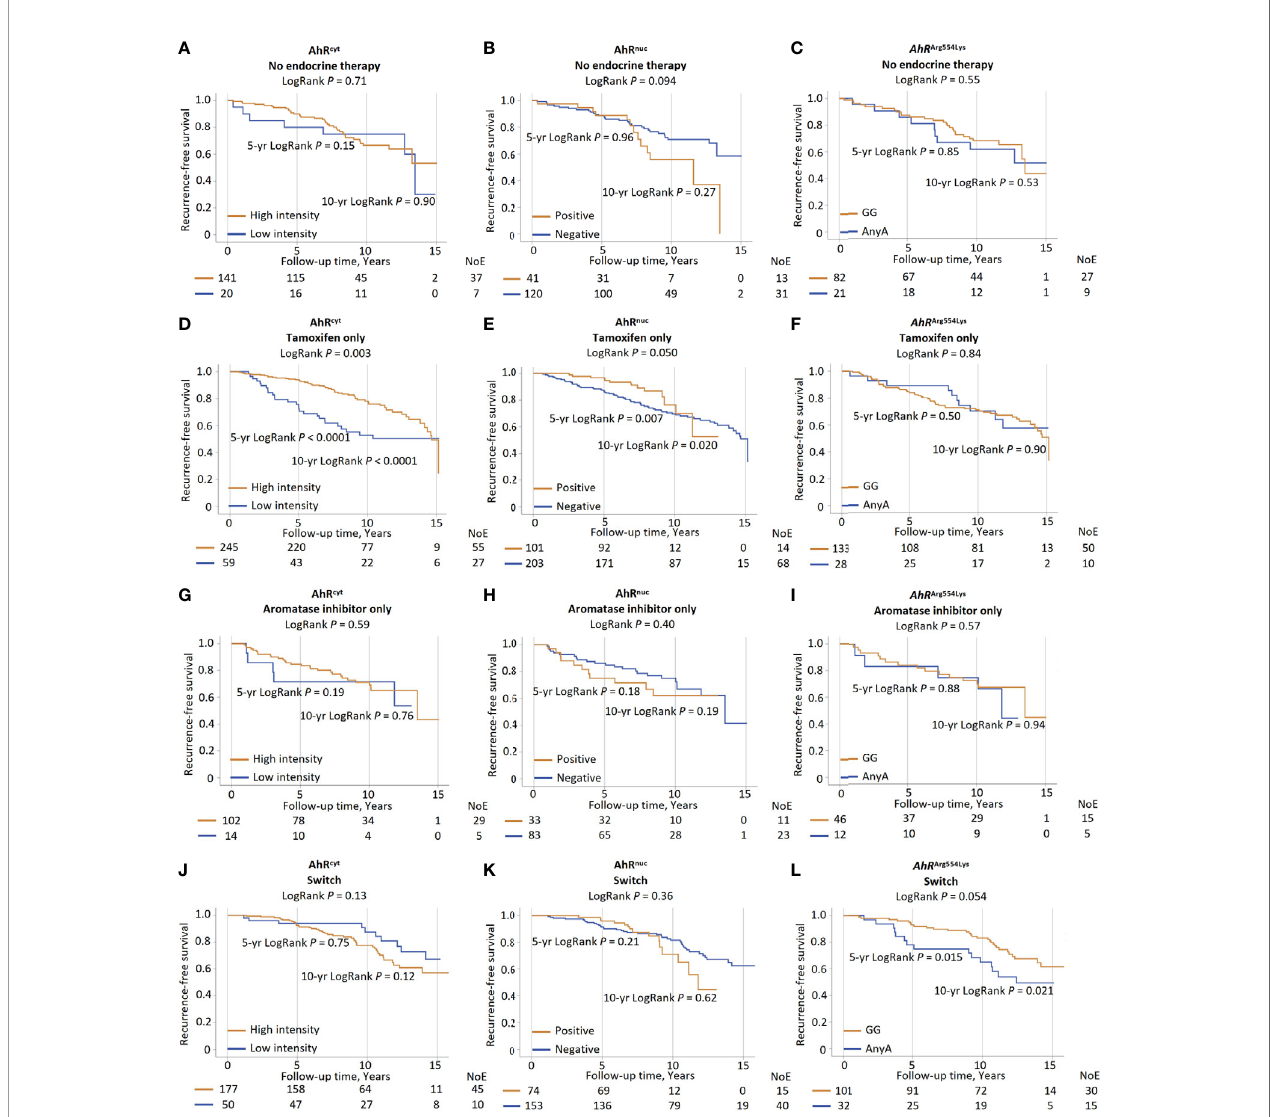
FIGURE 3 | High AhR cyt compared to low AhR cyt levels in patients with ER + tumors in relation to 5-year, 10-year and the entire follow-up recurrence-free survival in patients with (A) no endocrine therapy, (D) tamoxifen only, (G) aromatase inhibitors only, and (J) switch-therapy. Positive AhR nuc levels compared to negative AhR nuc status in relation to 5-year, 10-year, and the entire follow-up recurrence-free survival in patients with (B) no endocrine therapy, (E) tamoxifen only, (H) aromatase inhibitors only, and (K) switch-therapy. AhR Arg554Lys GG compared any A genotype in relation to 5-year, 10-year and the entire follow-up recurrence- free survival in patients with (C) no endocrine therapy, (F) tamoxifen only, (I) aromatase inhibitors only, and (L)